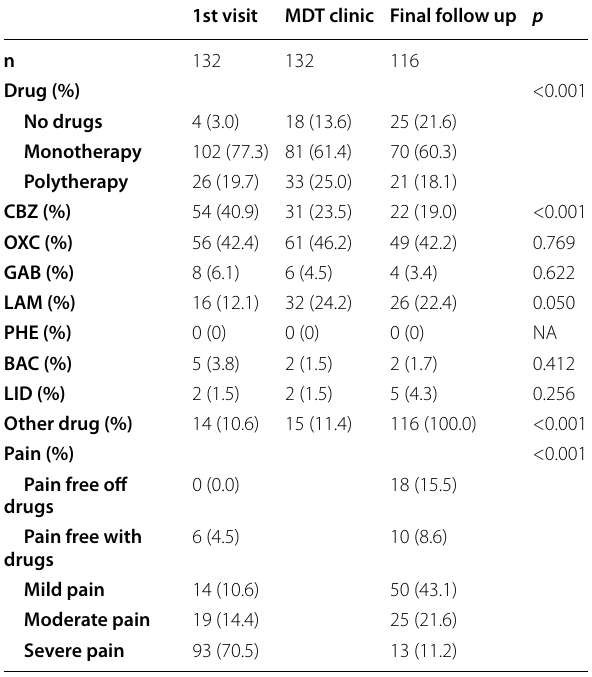
Table 2 Details of medically managed patients